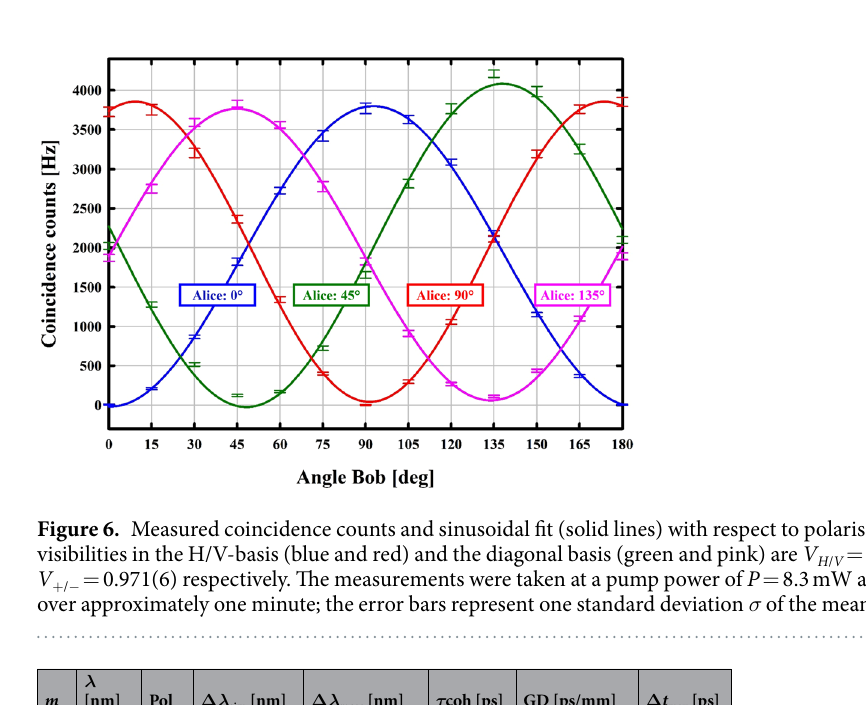
Figure 5. Wavelength distribution of the down-converted photons. The solid (dashed) line represents photons from JSI + (JSI − ). Figure ( a ) depicts the spectrum of the horizontally and vertically polarised shortwave photon. The spectra of the longwave photons are shown in ( b ). Spectral filtering of the longwave photons matches the two spectra, as depicted in ( c ).